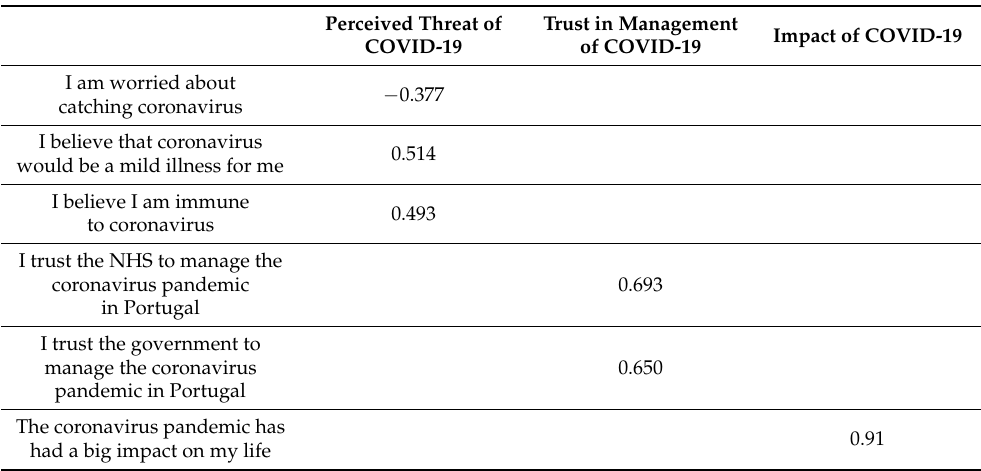
Table A2. Principal component loadings, following varimax rotation for items relating to attitudes and beliefs about